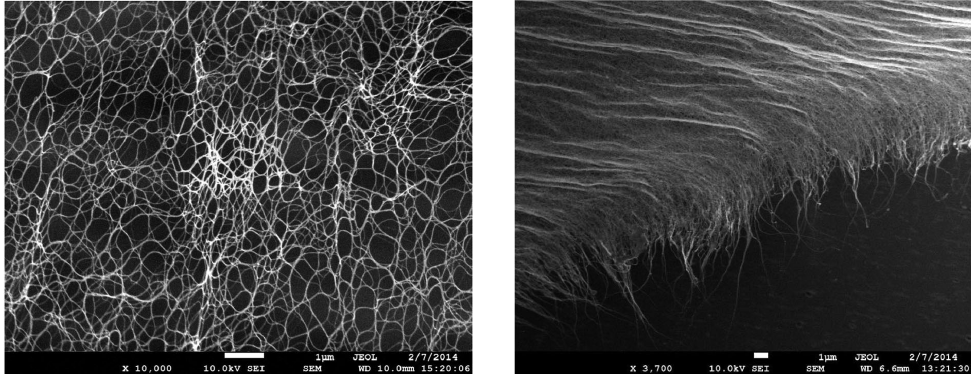
FIG. 1. The SEM images for the SWNT films with a density of 0 . 1 mg = cm 3 (left panel) and 1 mg = cm 3 (right panel) synthesized by an aerosol method with different deposition times.